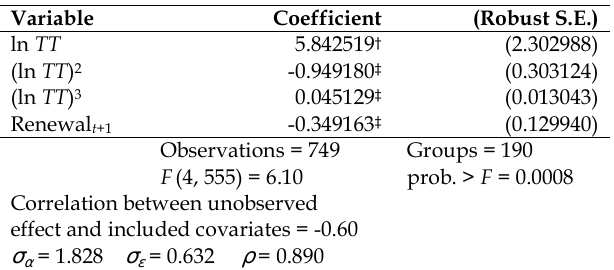
Table 5. Results from a FE model for infrastructure operation costs with renewal dummy - Model IV